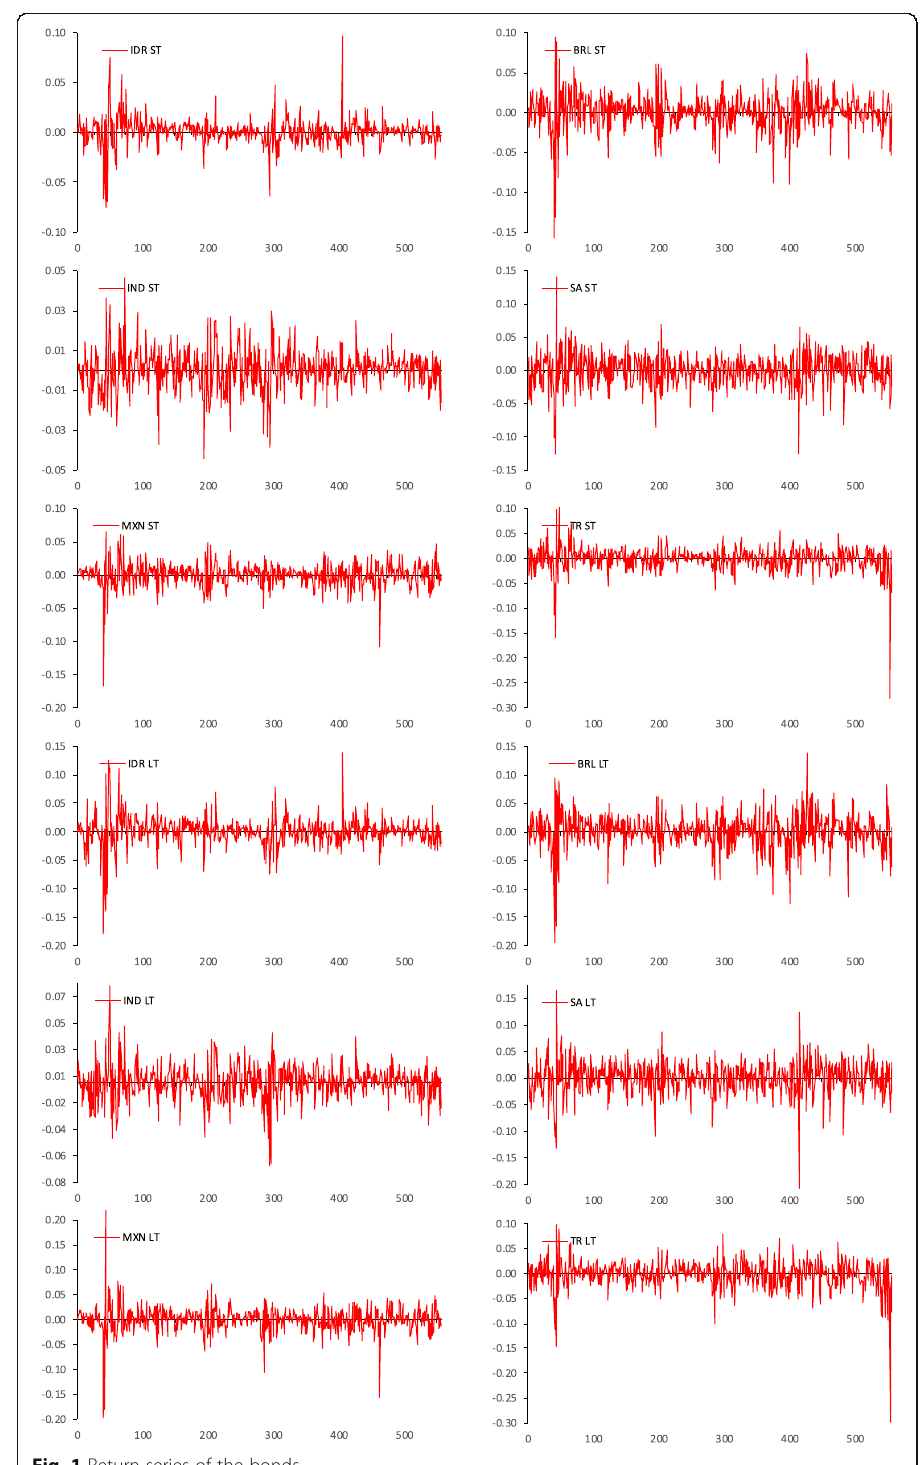
Fig. 1 Return series of the